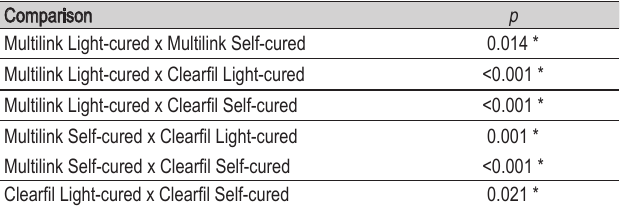
Table 3 - Tukey`s test for multiple comparisons among experimental groups, except for RelyX ARC.